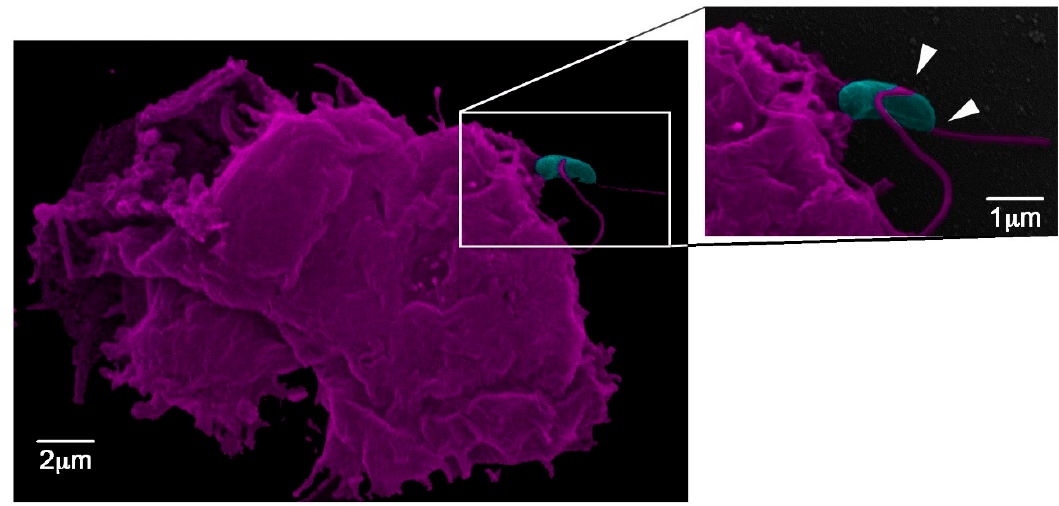
Figure 3. Acanthamoeba castellanii interaction with yeasts of Sporothrix brasiliensis . The white arrows depict the acanthapodes as projections from the A. castellanii surface in close contact with the fungal cell wall outer layer.